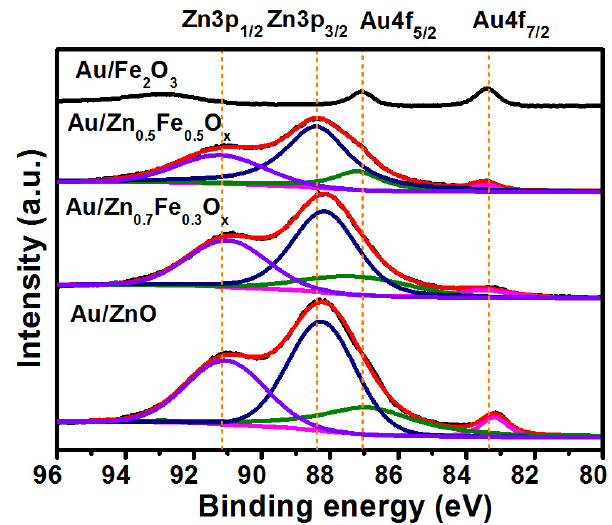
Figure 5. XPS spectra of Au 4f region in the selected nanocatalysts of Au/ZnO, Au/Zn 0.7 Fe 0.3 O x , Au/Zn 0.5 Fe 0.5 O x , and Au/Fe 2 O 3 .